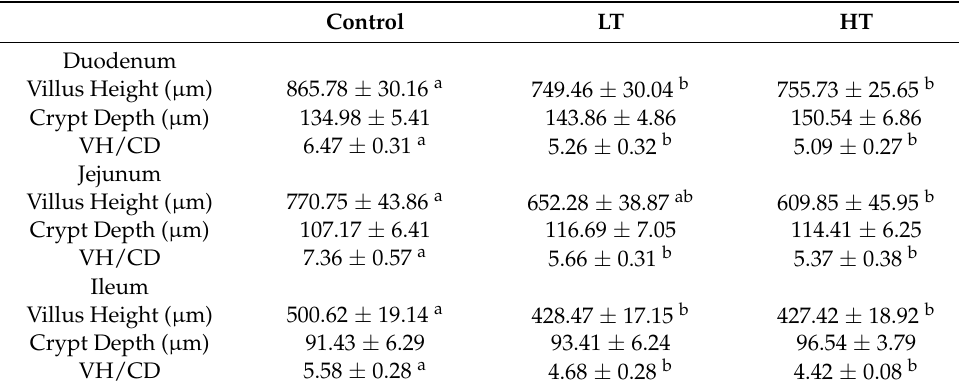
Table 2. Effect of TA on the intestinal morphology of Brandt’s voles. Control LT